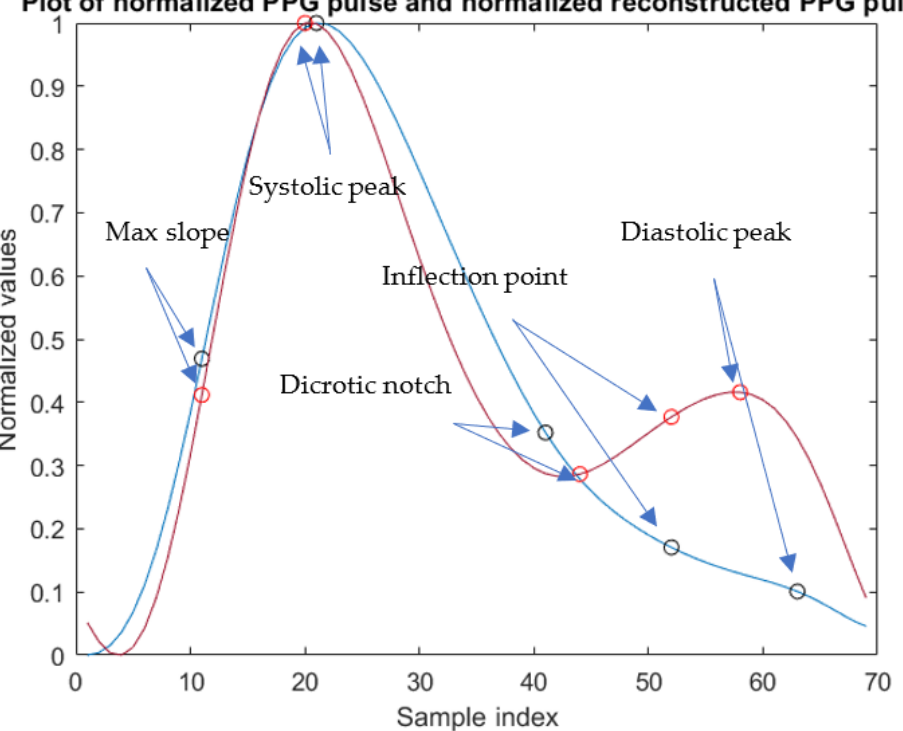
Figure 5. Pulse PPG before (blue) and after (red) the use of MODWT.